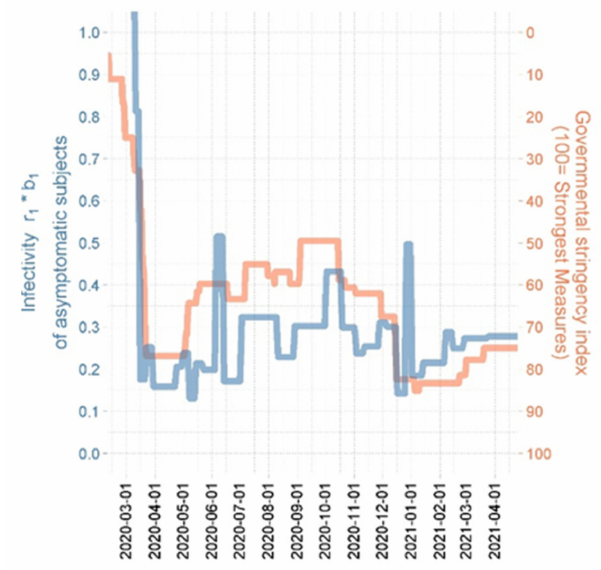
Figure 5. Relationship between estimated step function of infectivity of asymptomatic subjects and the Federal Government stringency index (GSI). The GSI [50] is a composite measure based on nine response indicators including school closures, workplace closures, and travel bans, rescaled to a value from 0 to 100 (100 = strictest). If policies vary at the level of federal states, the index is shown for the state with the strictest measures. For background info see also [51]. Colors of curves correspond to different